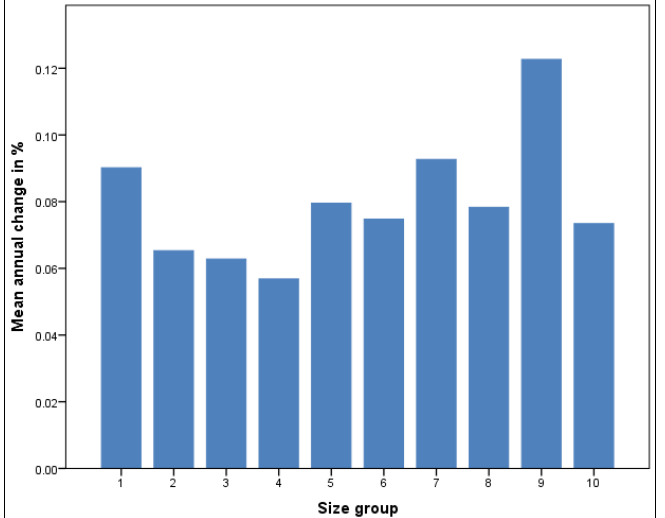
Figure 2. Mean annual rate of change by protected area group size showing slightly greater average change in the five larger size groups than the five smaller size